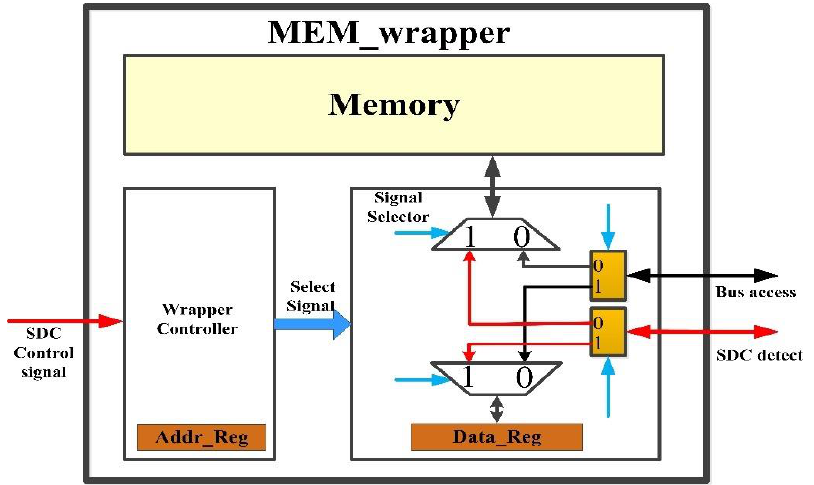
Figure 6. The structure of